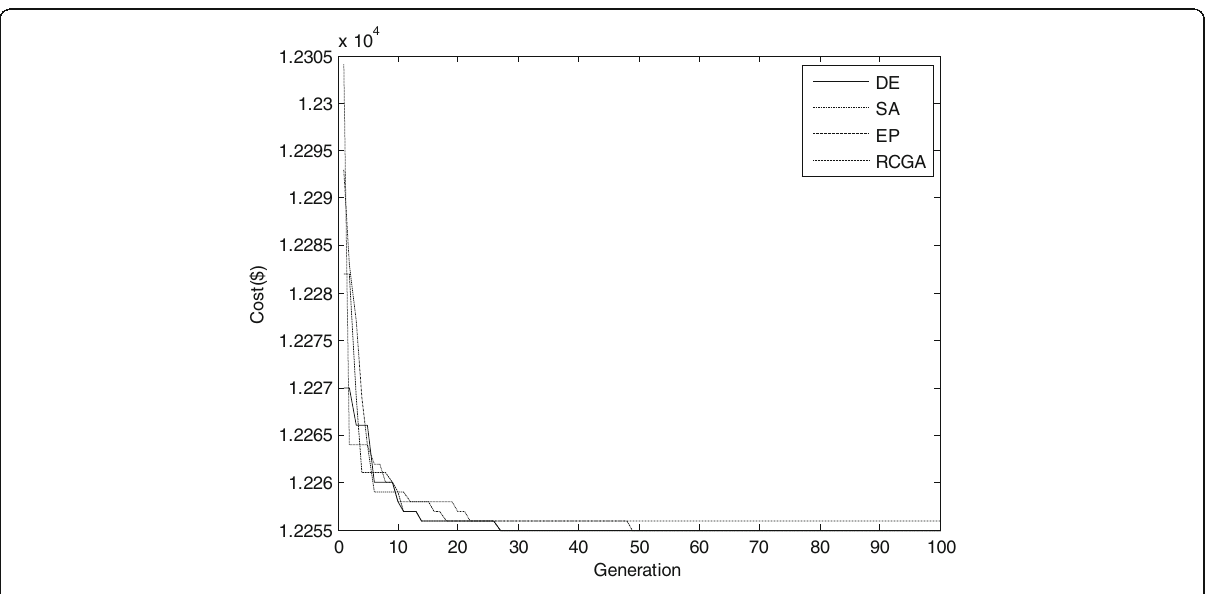
Fig. 1 Cost convergence characteristic of test system